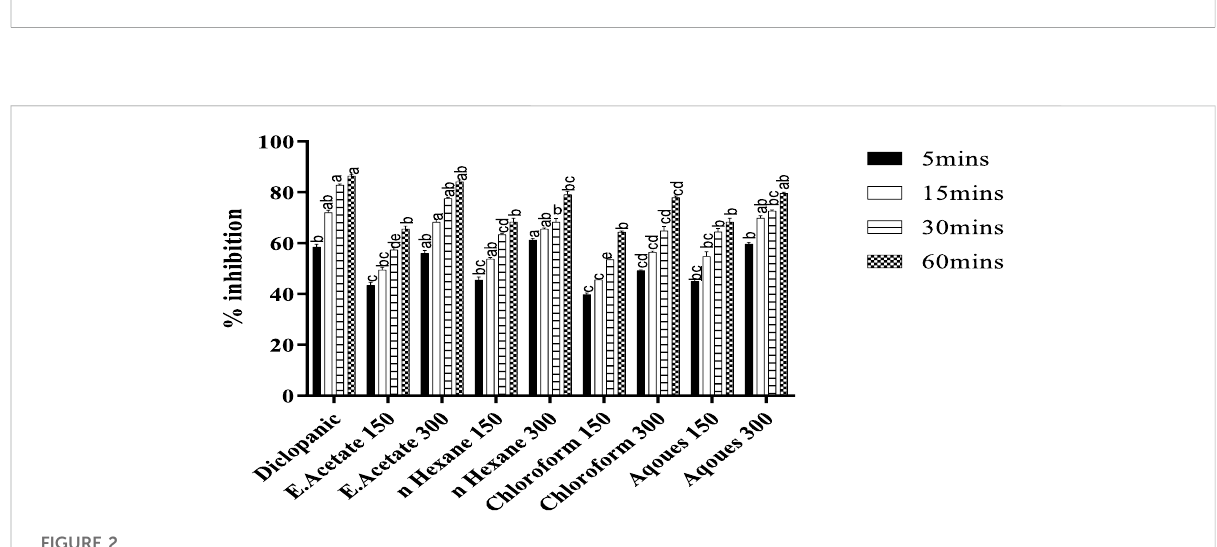
FIGURE 1 Anti-in fl ammatory activity of different fractions of Justicia adhatoda at doses of 150 and 300 mg/kg in carrageenan-induced paw edema in Swiss albino mice after 1, 2, 3, and 4 h. Various bars represent statistical difference at p < 0.05.